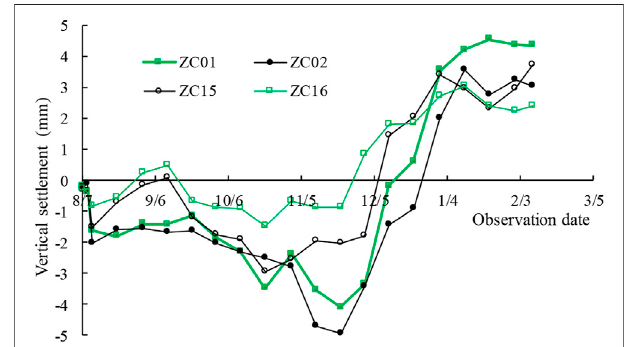
FIGURE 8 | Vertical deformation of soldier pile